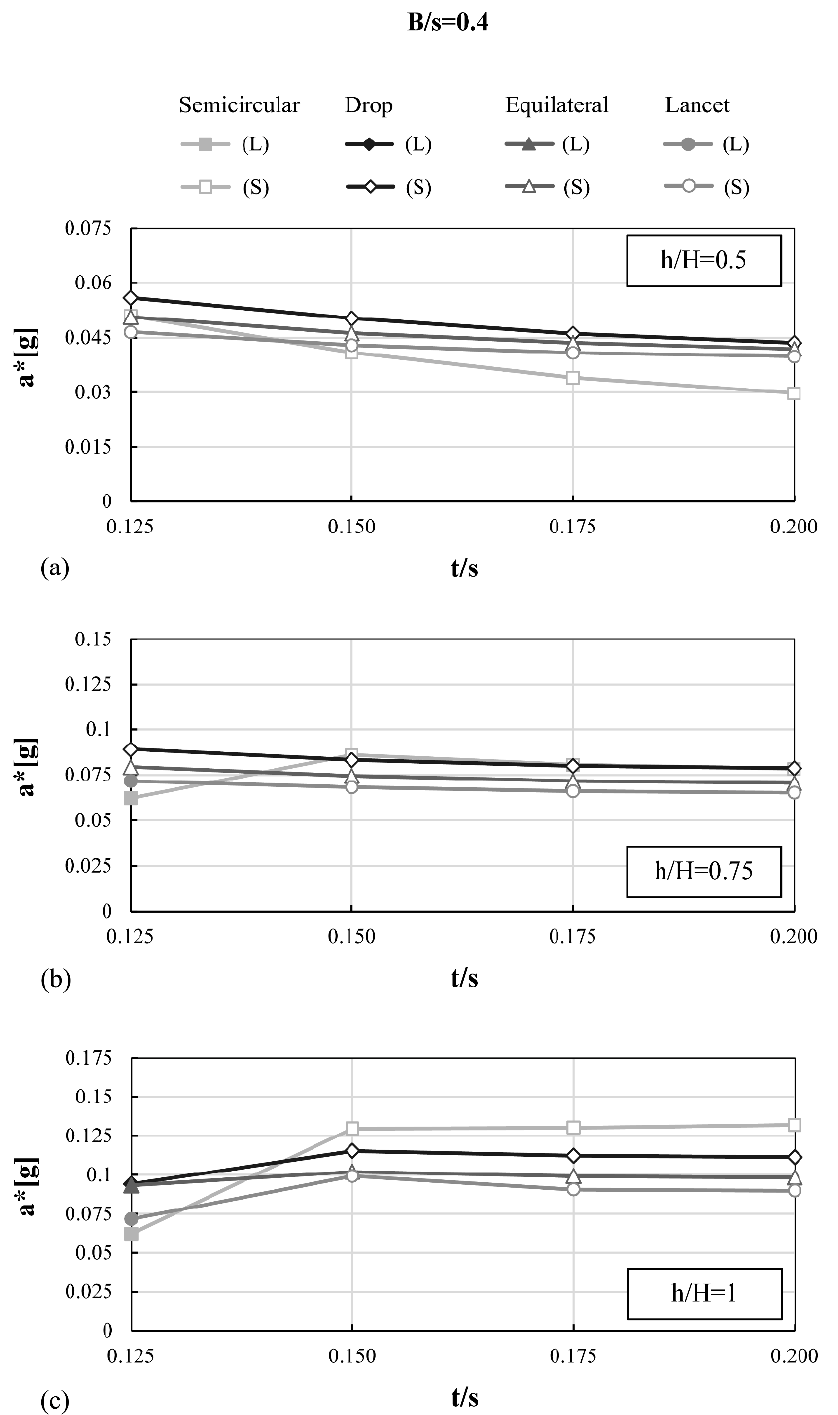
Figure 12. Values of a* for each considered eccentricity, each h/H configuration and B/s = 0.4, expressed with respect to the t/s ratio: ( a ) h/H = 0.5, ( b ) h/H = 0.75 and ( c ) h/H = 1.0. Local mechanism (L) or semi-global mechanism (S) are highlighted.